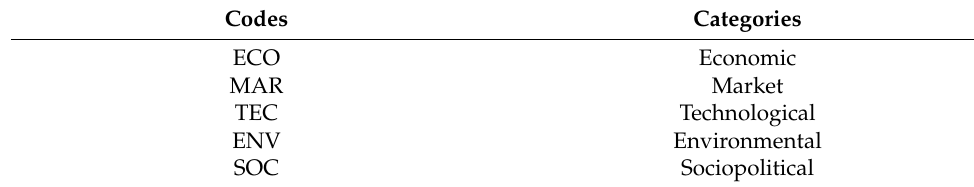
Table 2. Category names and codes.